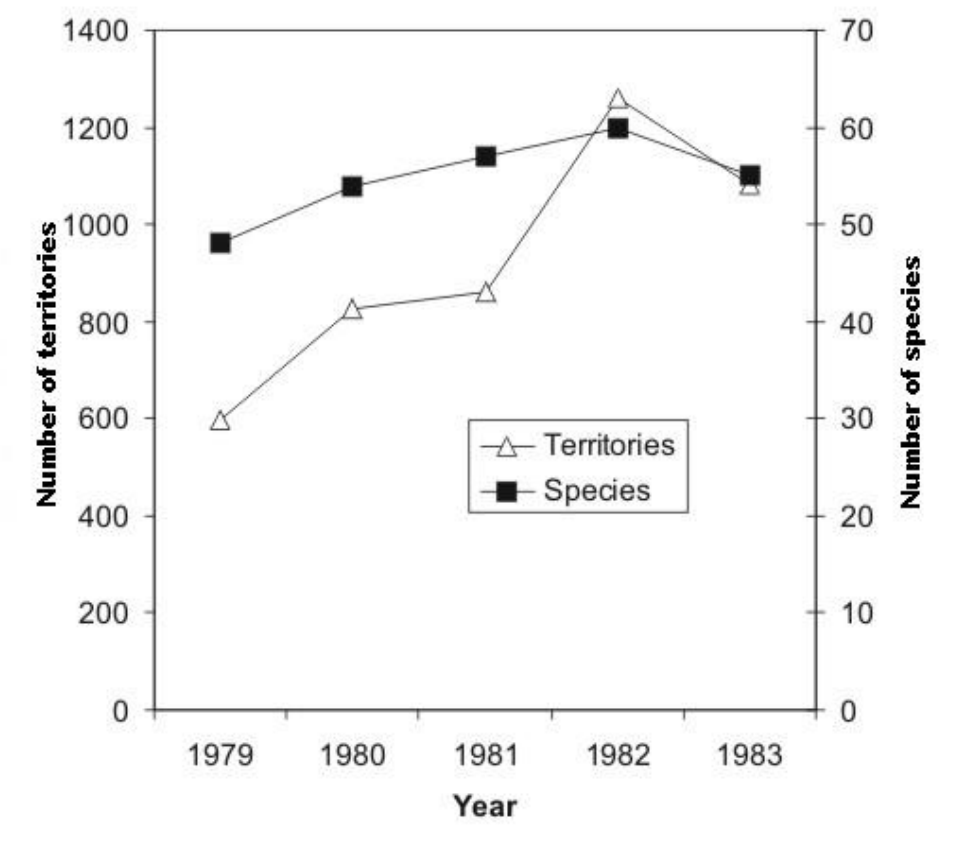
Fig. 2 . Number of bird territories and the number of species in all 18 plots from 1979 to